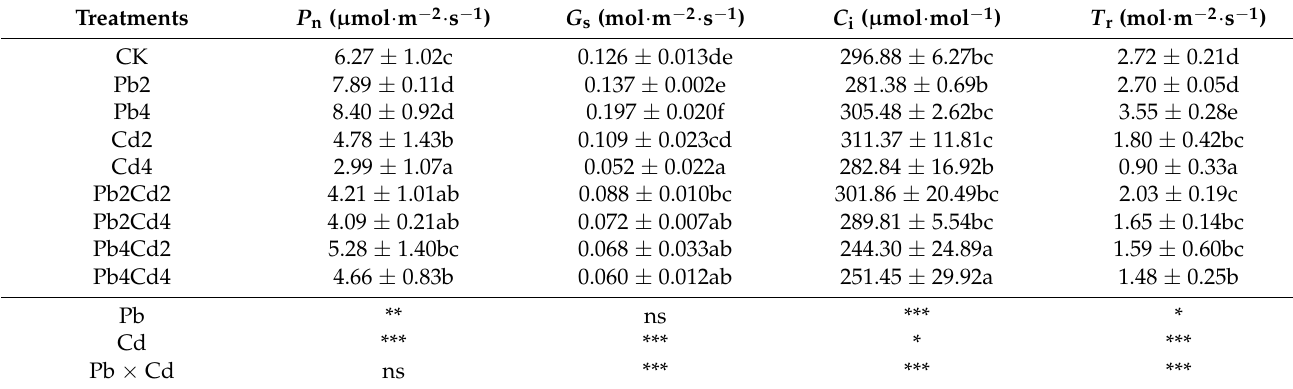
Table 4. Effects of individual and combined Pb and Cd stress on photosynthetic characteristics in F . parvifolia. The post hoc test used for the estimation of the significance level is the Duncan test. Different lowercase letters in the same column indicate significant differences at p < 0.05. Each value represents mean values ± SEs (n = 5). ns, p > 0.05; *, p < 0.05; **, p < 0.01; ***, p < 0.001.